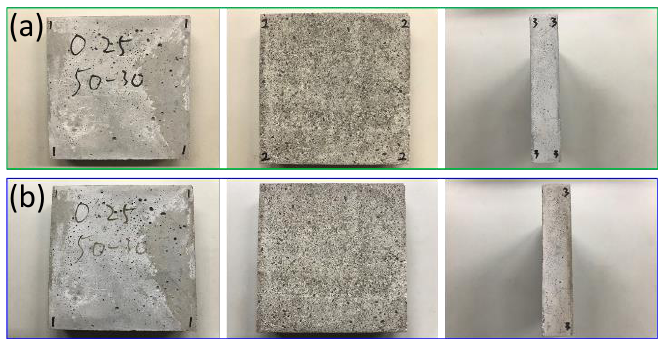
Figure 9. #40 − 50 − 30 − C/S = 0.25. ( a ) Before testing. ( b ) After testing.